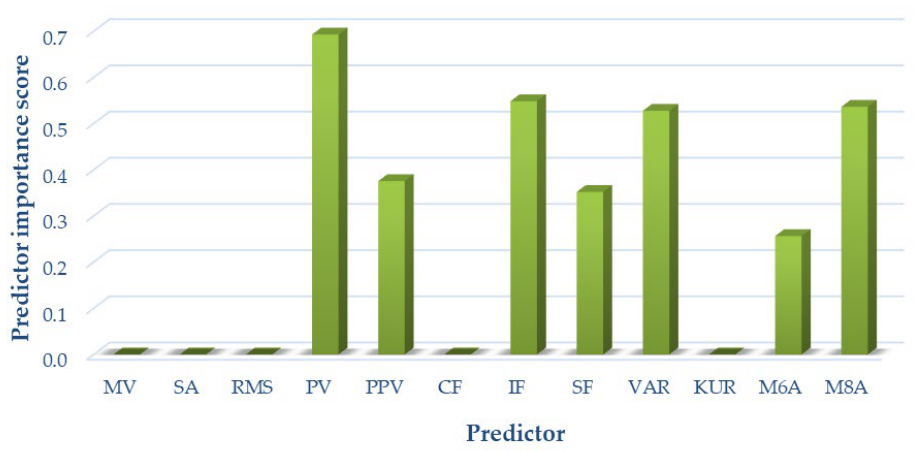
Figure 8. Selection of optimal features for variant I (OKC) .